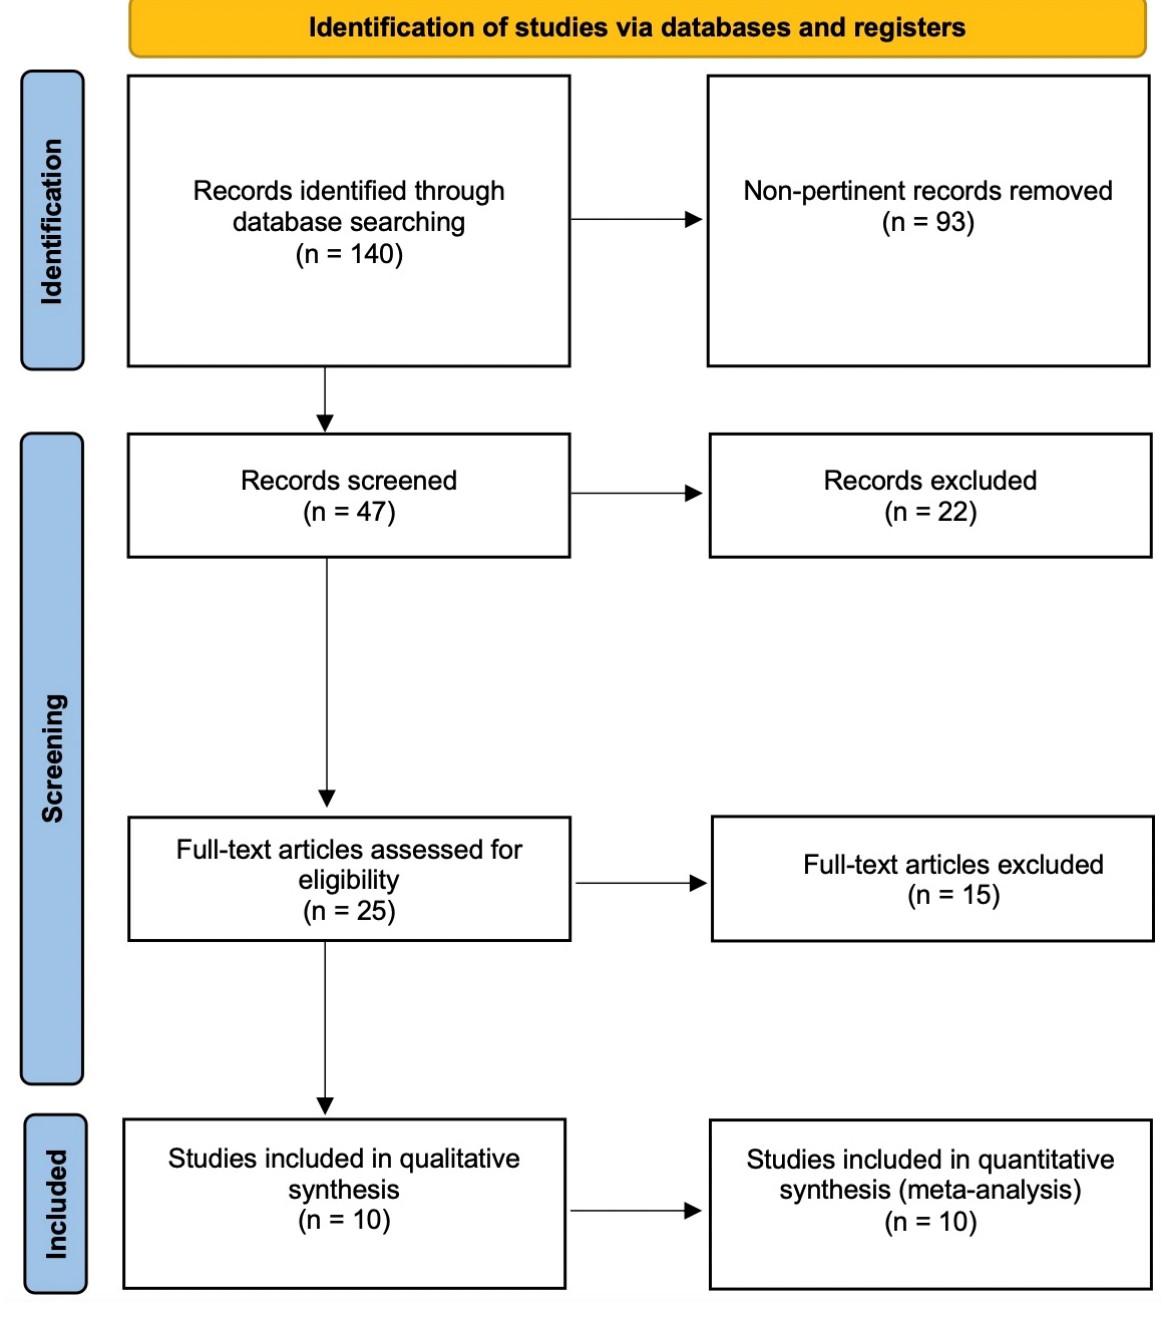
Figure 1. Literature search flowchart.